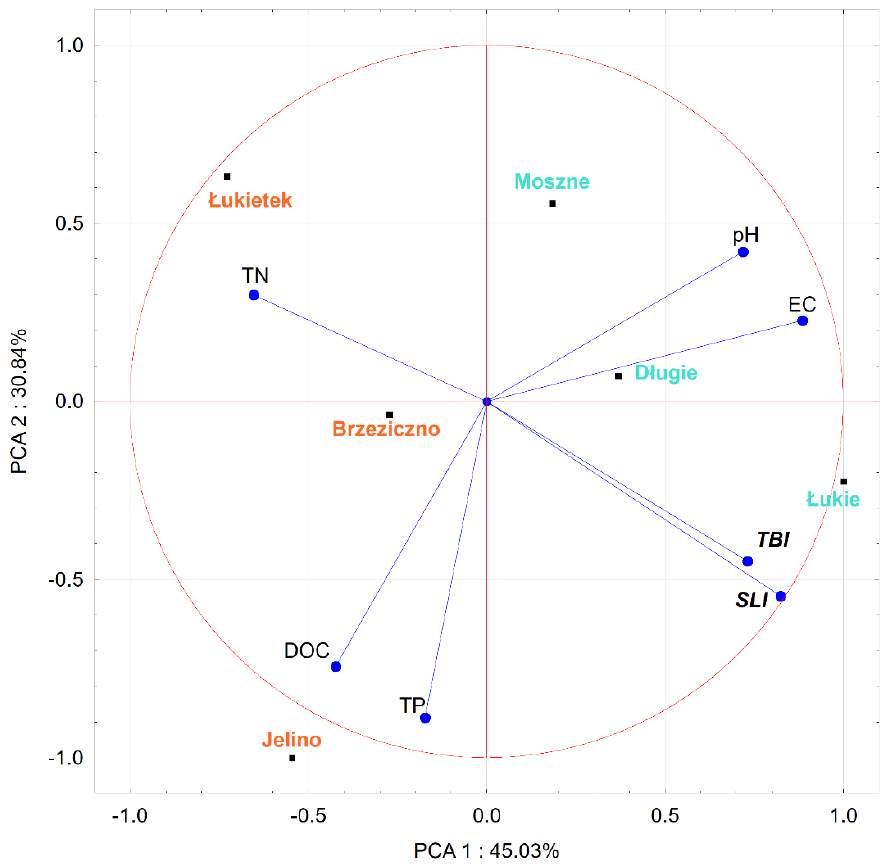
Figure 11. Principal component analysis biplot of the dataset. Reservoirs with aldrovanda popu- lations are marked in blue, and those taken into account as substitute habitats for the species are marked in red. TBI—total biomass increase, SLI—stem length increase.